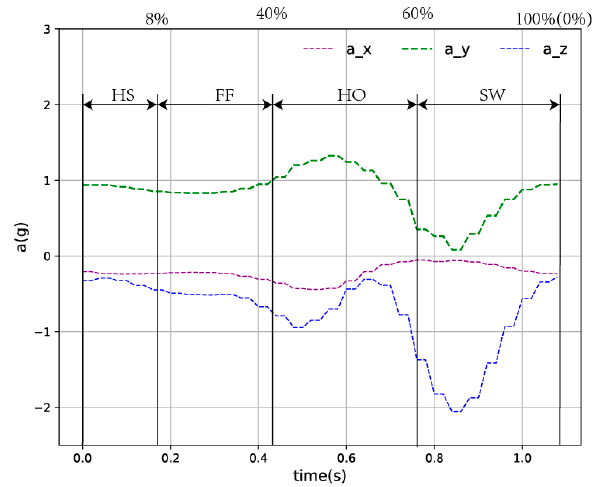
Figure 5. Phase-division diagram of gait.